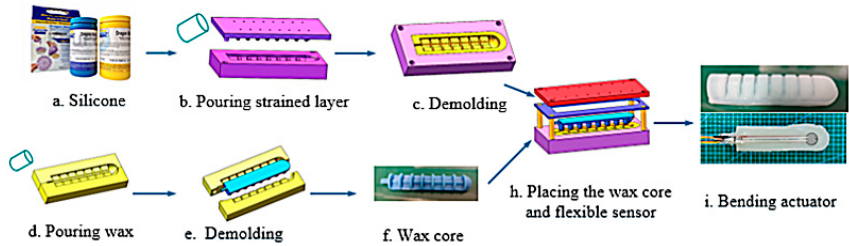
Figure 4. Manufacturing process of the bending actuator.